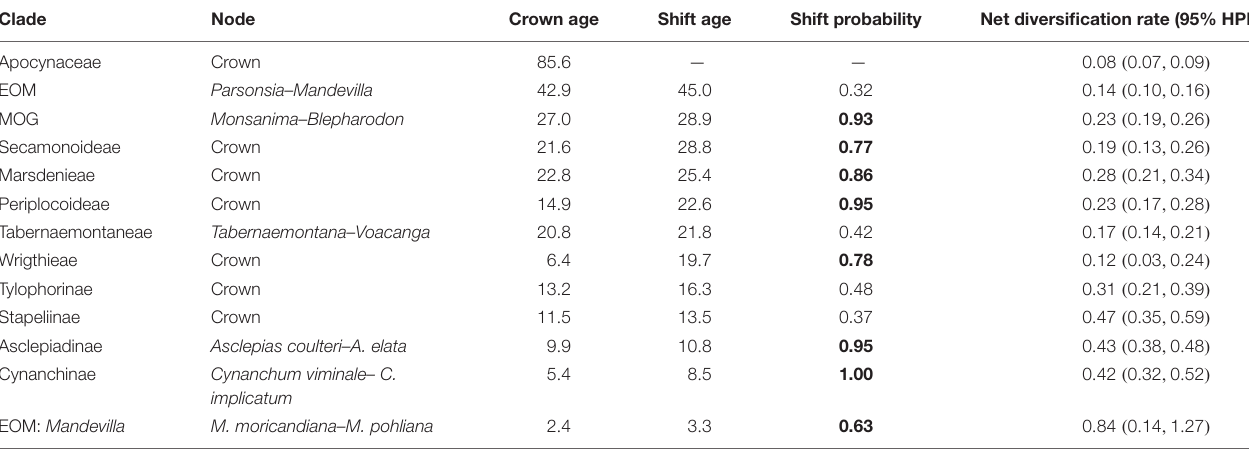
TABLE 3 | Shifts in net diversification rates inferred in the Bayesian analysis of macroevolutionary mixture (BAMM). Clade Node Crown age Shift age Shift probability Net diversification rate (95%